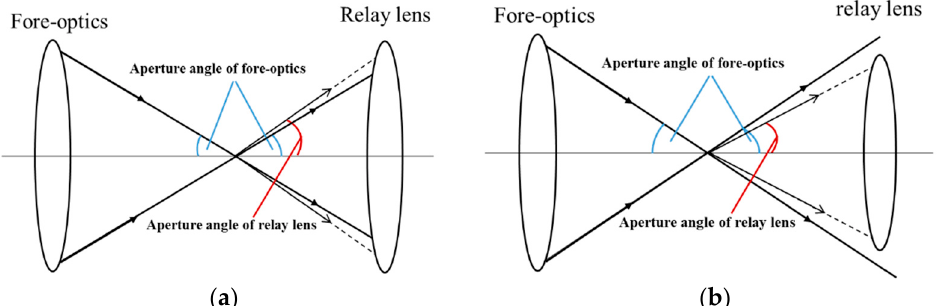
Figure 7. Aperture angle match diagram. ( a ) The aperture angle of the relay lens is greater than that of the fore-optics, and no vignetting will occur. ( b ) The aperture angle of the relay lens is less than that of the fore-optics, causing vignetting.